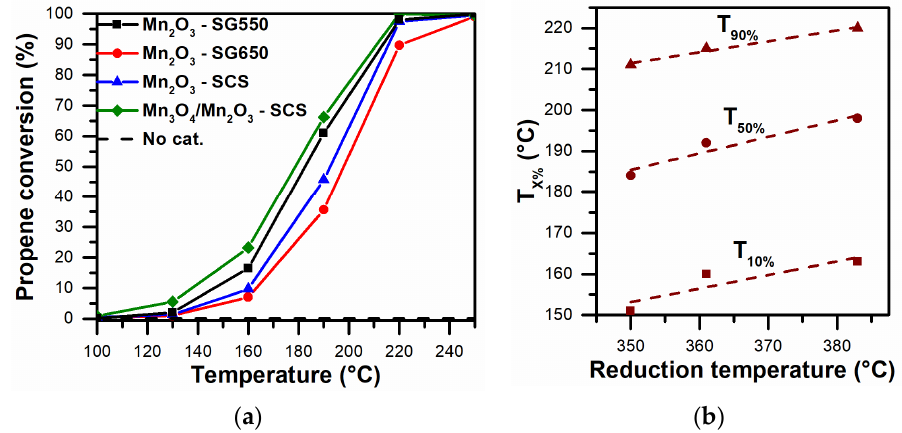
Figure 6. ( a ) Catalytic performances in the oxidation of C 3 H 6 and ( b ) correlation between the low- temperature reduction peak and the catalytic performance in C 3 H 6 oxidation (over Mn 2 O 3 catalysts) in terms of T 10% , T 50% and T 90% .